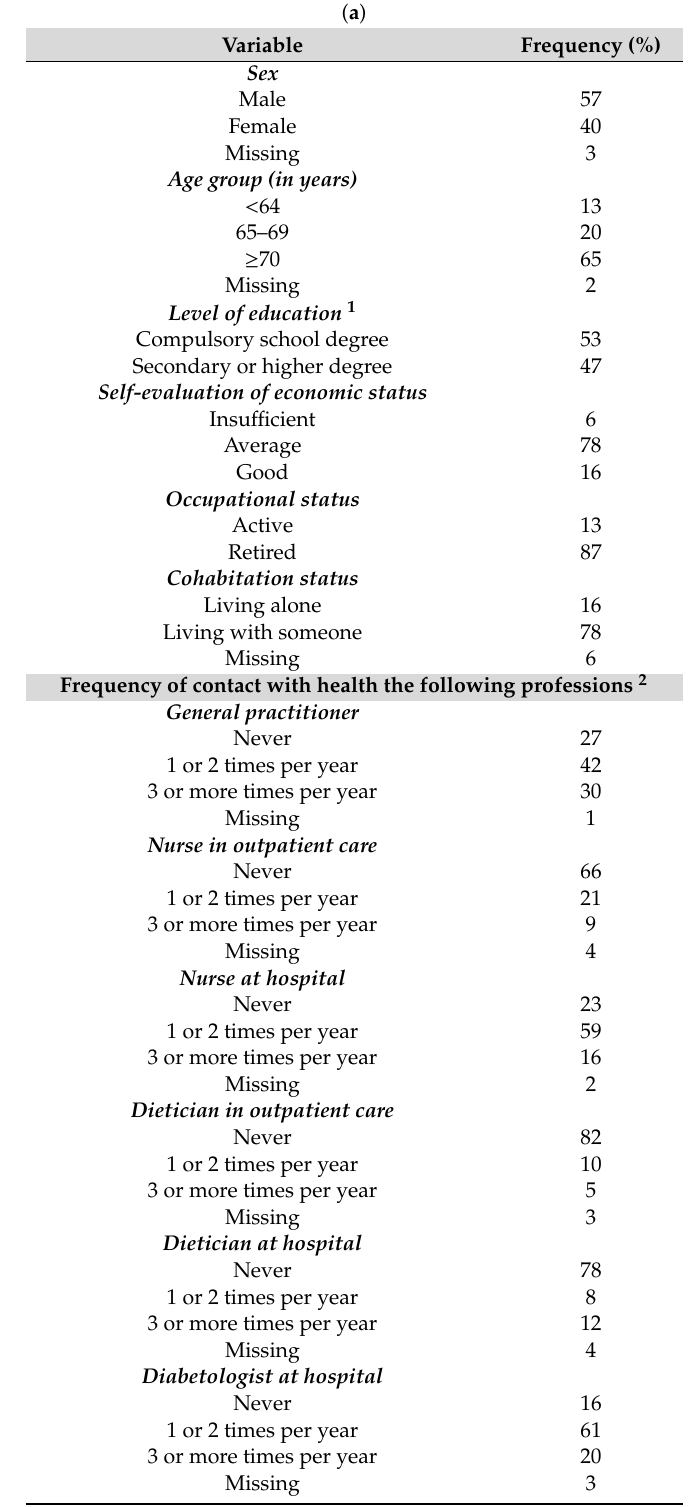
Table 1. ( a ) Descriptive characteristics of participants and their frequency of contact with health professions in the last year ( N = 100). ( b ) Clinical characteristics of participants ( N =